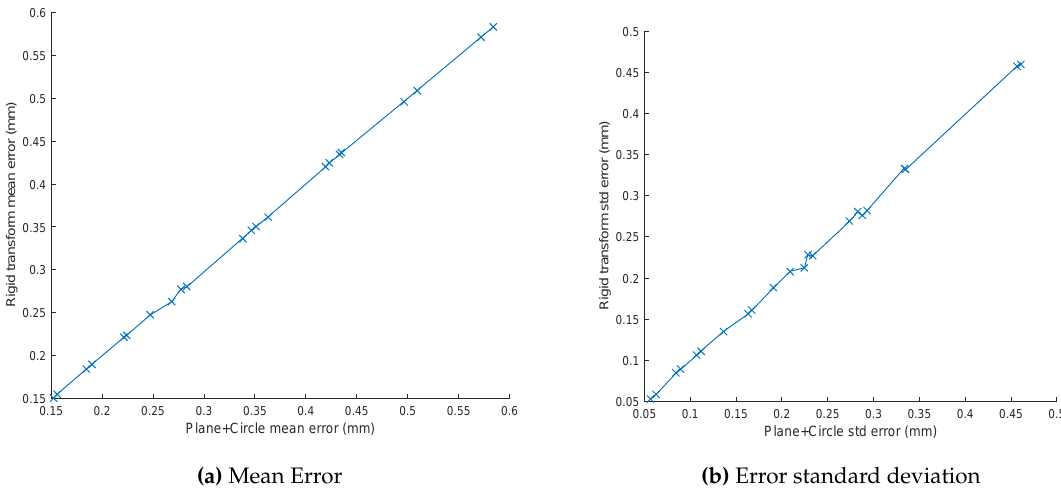
Figure 7. Comparison of both extrinsic calibration models. The mean difference between both models is equal to